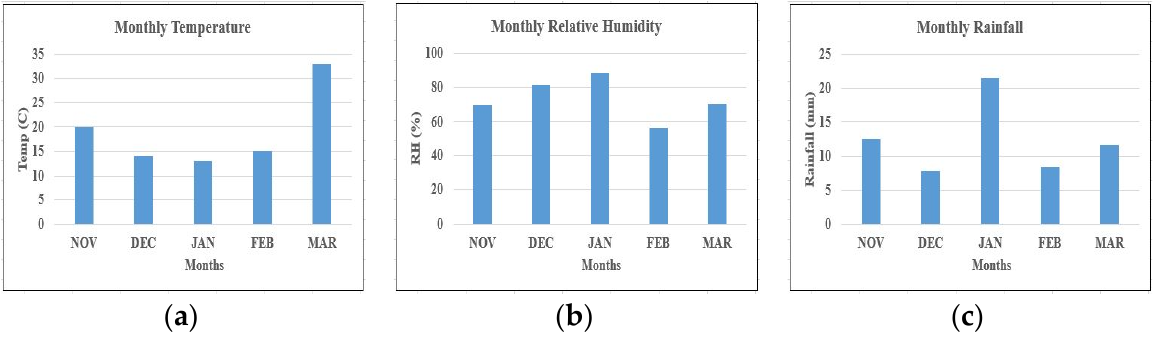
Figure 1. ( a ) Average monthly temperature; ( b ) monthly relative humidity; ( c ) average monthly rainfall.